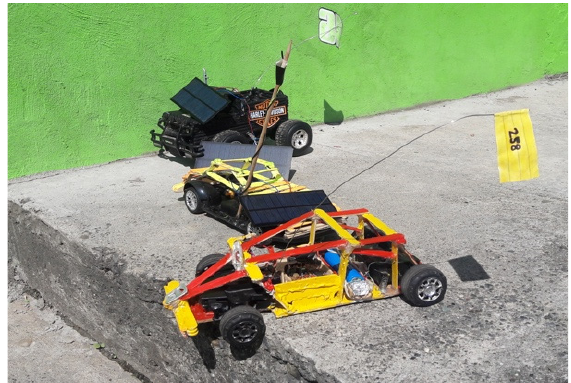
Figure 7. Toy cars built through mathematics as a way of doing art from the concept of solar energy.